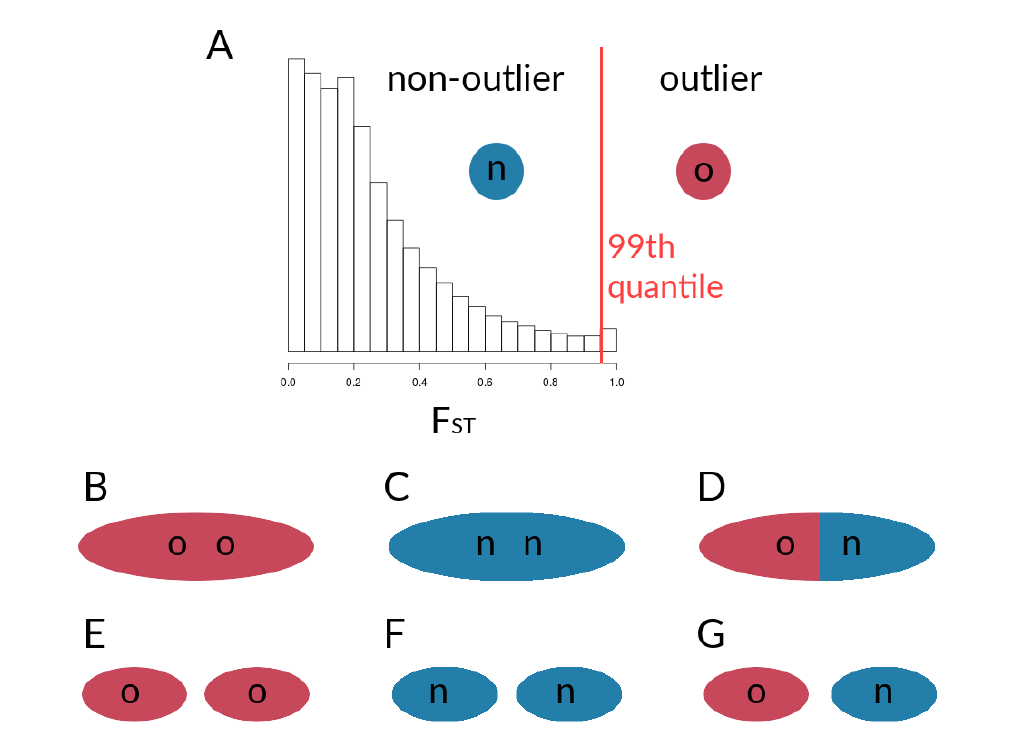
Figure 3. Schematic of comparisons for the calculation of correlation coefficients between sets of loci within species. ( A ) Designation of outlier loci based on F ST , which was used for the calculation of r 2 for ( B ) outlier loci within the given chromosome, ( C ) non-outlier loci within the given chromosome, and ( D ) outlier loci with non-outlier loci within the given chromosome. Further, r 2 values werecalculated for sets of loci on the given chromosome with respective sets sampled from all other chromosomes, with ( E ) outlier loci vs. outliers from other chromosomes, ( F ) non-outlier loci vs. non-outliers from other chromosomes, and ( G ) outlier loci vs. non-outliers from other